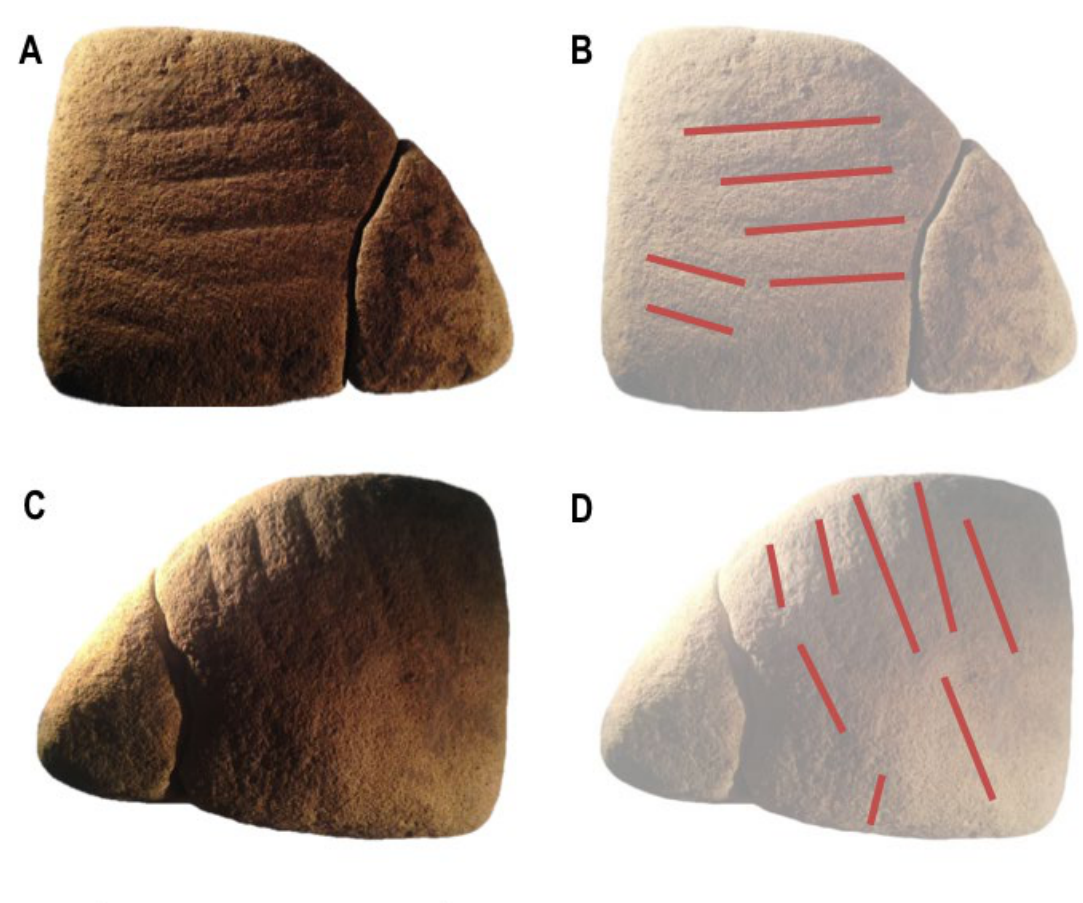
Figure 3. Grinding stone specimen 491 with distinctive grinding wear, including areas of abrasion and macroscopically visible grooves. A-B) Surface 1: note the four parallel grooves running perpendicular to the fresh break; C-D) Surface 2: note the five parallel grooves running parallel to the fresh break. Scale bar is 5